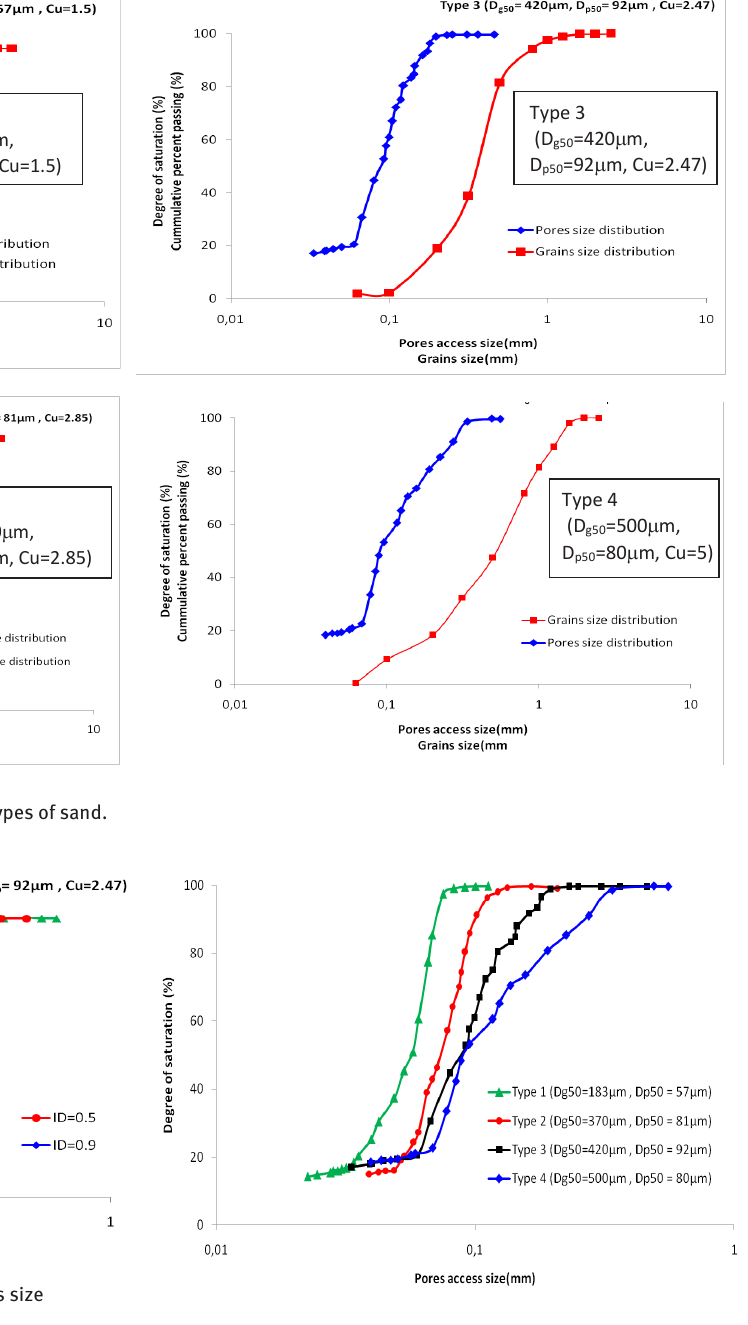
Figure 17: Comparison between the pore-access sizes of four types of